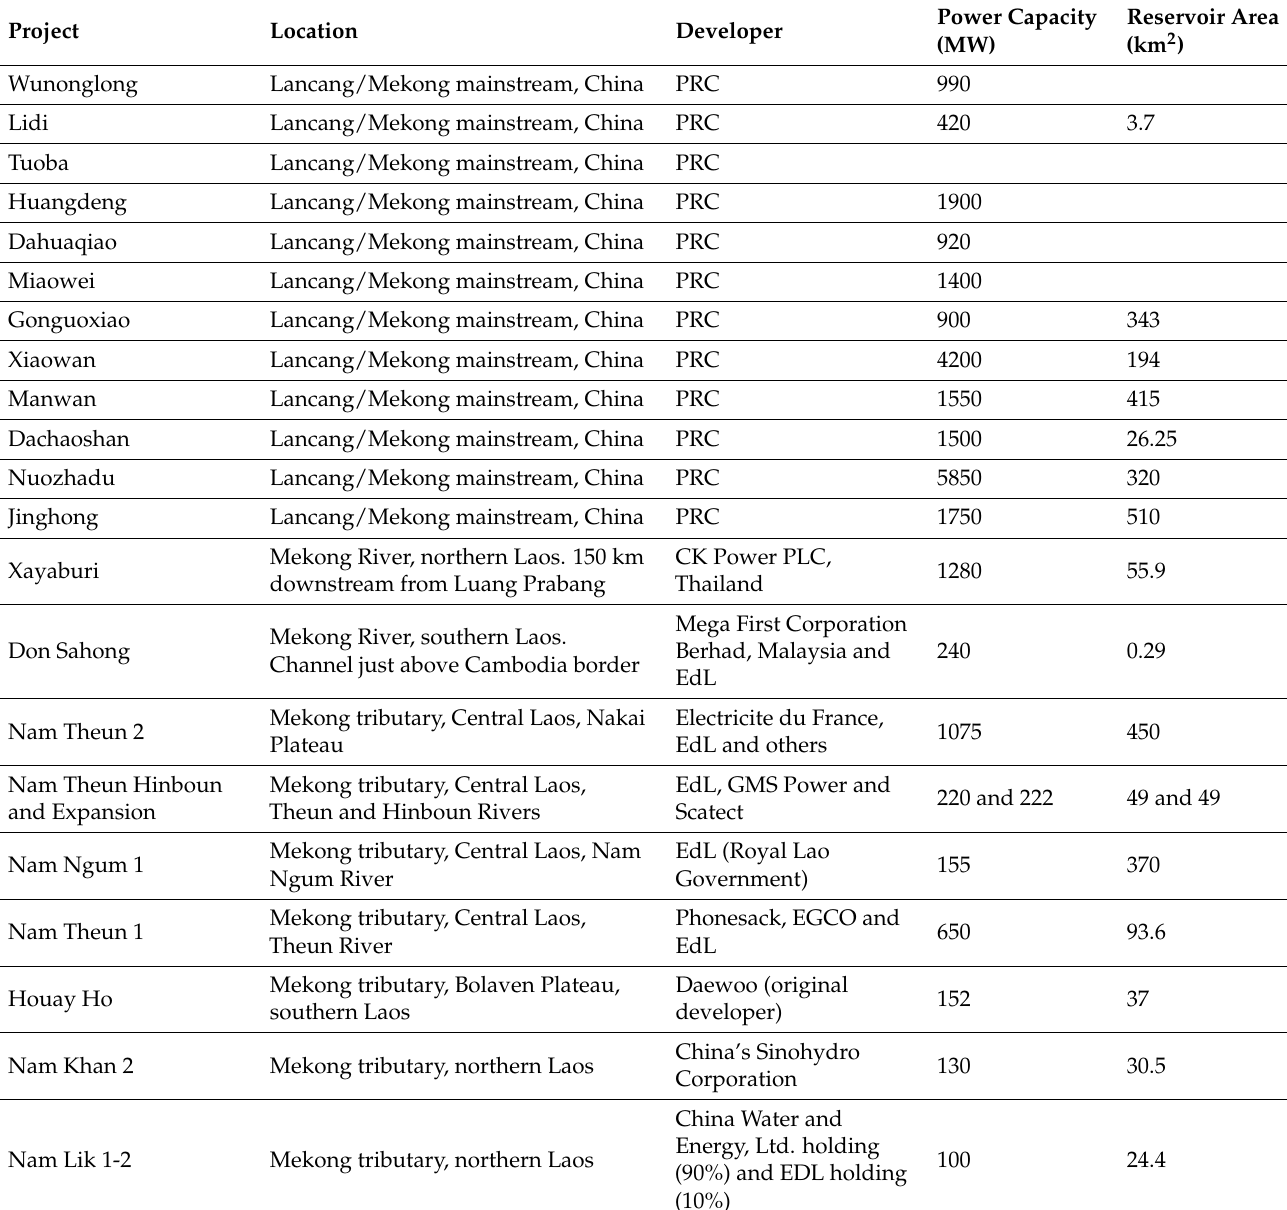
Table 1. List of Mekong River Basin dams with 100 MW electricity generating